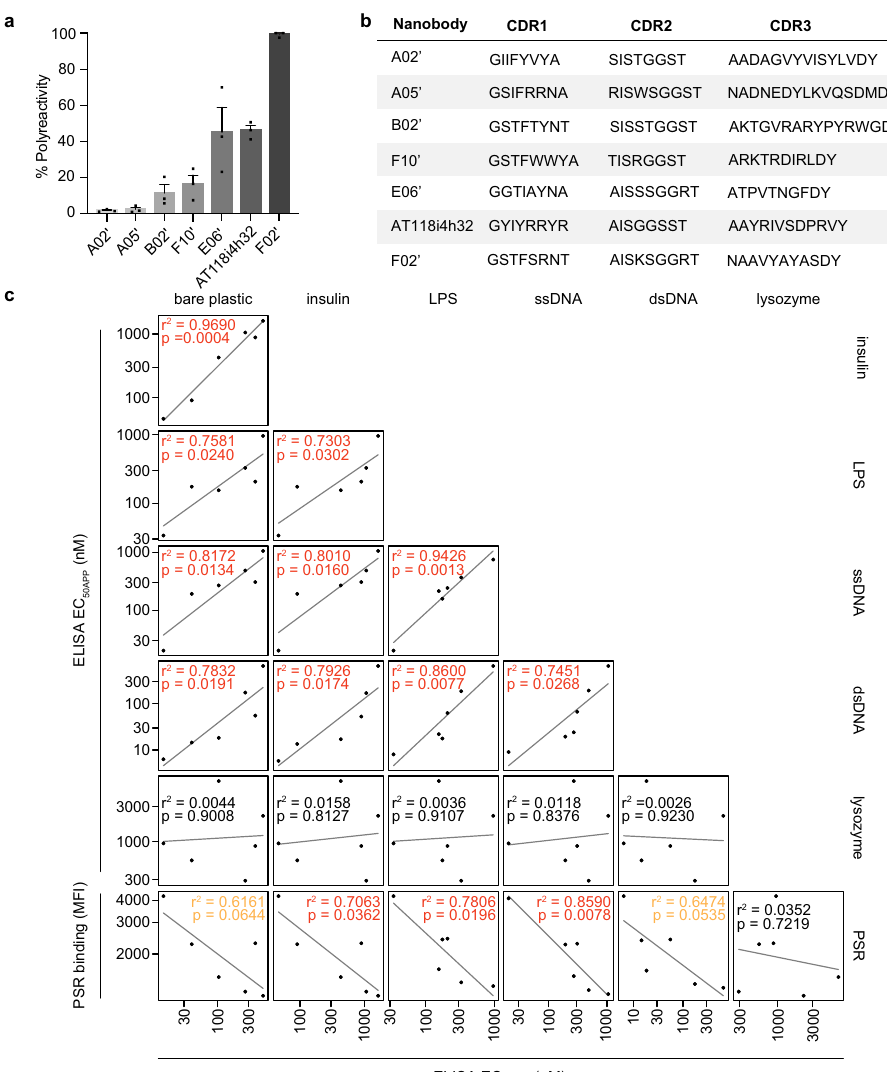
Fig. 2 | Properties of puri fi ed nanobodies exhibiting varying degrees of poly- reactivity. a Spodoptera frugiperda (Sf9) insect cell PSR staining of single nano- bodies isolated from FACS sorts. Data are mean +/ − SEM of three independent biological experiments performed in technical triplicate. Polyreactivity levels are normalized with respect to the highest clone (Nb F02 ’ ). b CDR sequences of